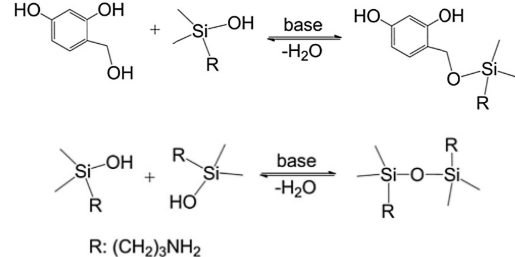
Scheme 7. Mechanism of the reaction between RF and APTES under base condition [78]. ( a ) the hydrolysed species of APTES (Si-OH) reacts with hydroxymethylated R; ( b ) Si-OH of APTES reacts with each